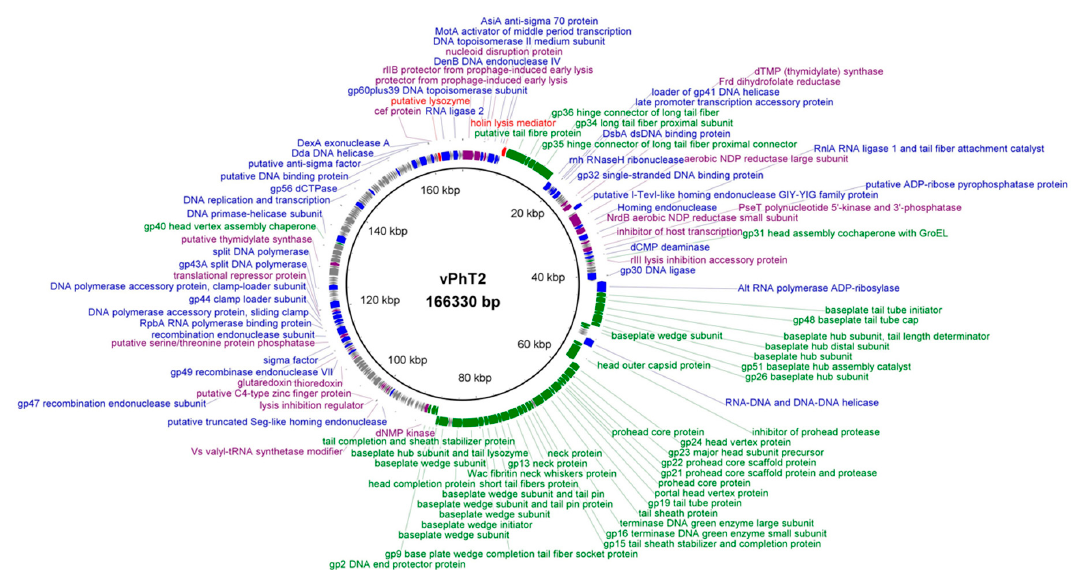
Figure 3. Graphic circular map of vPhT2 genome and its predicted open reading frames (ORFs) (NCBI accession number: MN864865). From inside to outside: the scale units in kilo base pairs (kbp), predicted genes on forward strand and predicted genes on reverse strand. Predicted genes are coloured according to their function (green = structural and morphogenesis proteins, blue = DNA replication and transcription, red = host lysis, purple = other functions and grey = hypothetical proteins with unknown function). The genome map was drawn using the BLAST Ring Image Generator (BRIG) software, version 0.95, The University of Queensland, Brisbane, Australia.